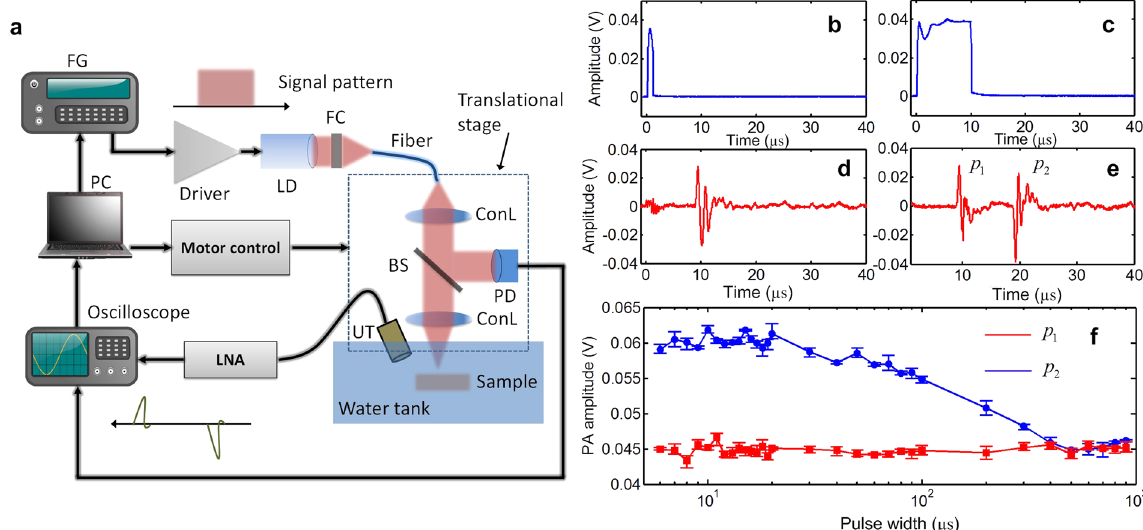
Figure 3. ( a ) The schematic of the experimental setup. FC: function generator; LD: laser diode; FC: fiber coupler; ConL: condenser lens; BS: beam splitter; PD: Photodiode UT: ultrasound transducer; LNA: low-noise amplifier. ( b , c ) The light illumination signal detected by the photodiode with pulse width of 1 µ s and 10 µ s. ( d , e ) The measured LDPA signals with 1 µ s and 10 µ s pulse width laser illumination. ( f ) Amplitudes of first PA signal (red line, square symbol) and second PA signal (blue line, circle symbol) by sweeping the pulse width of the laser